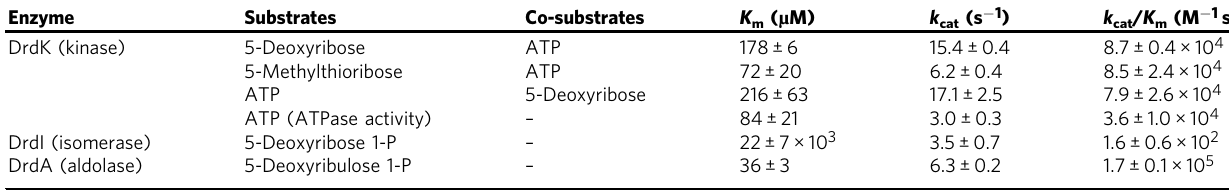
Table 1 Kinetic characterization of the three 5-deoxyribose-metabolizing enzymes